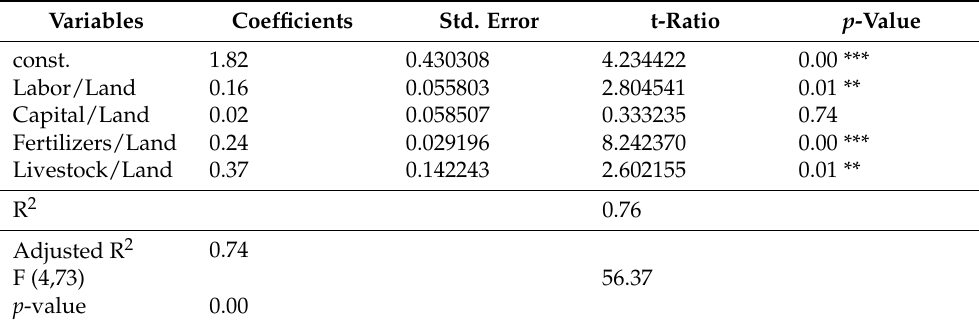
Table 1. Estimation of land productivity function (OLS